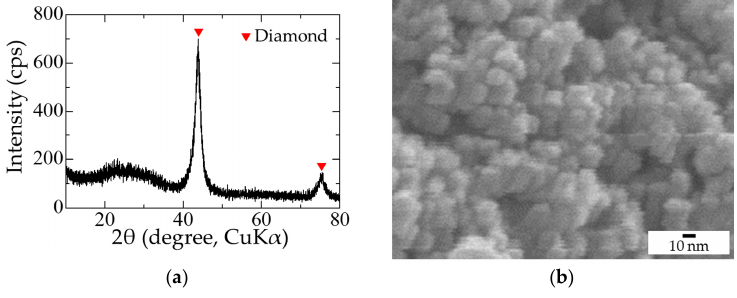
Figure 1. Characterization of initial nanodiamonds (NDs): ( a ) X ‐ ray diffraction; ( b ) scanning electron microscope.